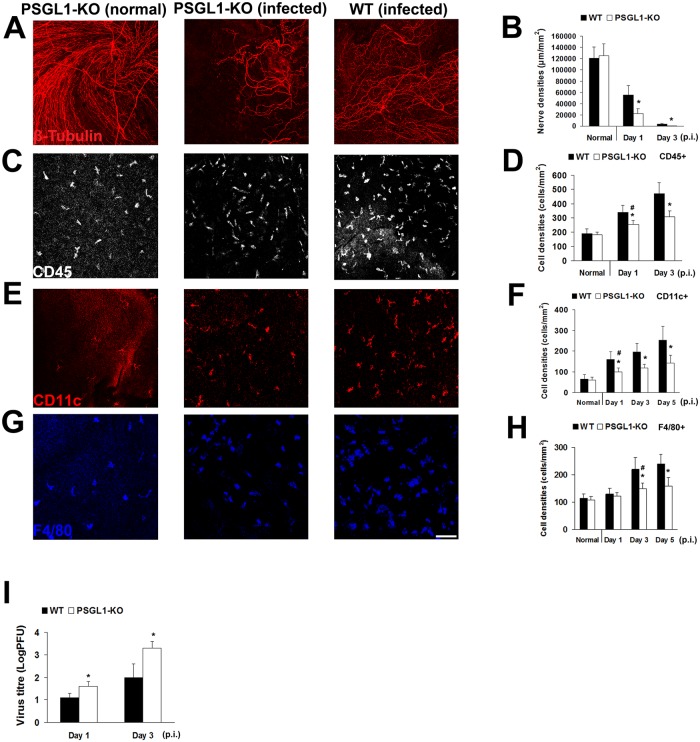
Corneal nerve damage in primary acute herpes simplex keratitis is due to viral proliferation and not corneal inflammation.
A, B: Corneal nerve density was significantly decreased in PSGL1-KO mice as compared to WT mice after HSV-1 infection (n = 5/time point). C, D: The number of corneal inflammatory cells was significantly decreased in PSGL1-KO mice compared to WT mice after HSV infection (n = 5/time points). E, F: Corneal cDC density was significantly decreased in PSGL1-KO mice compared to WT mice after HSV infection. The increase of cDCs in PSGL-1 KO mice as compared to normal controls suggests potential differentiation from progenitor cells or proliferation (n = 5/time point). G, H: The number of corneal MΦs was significantly decreased in PSGL1-KO mice as compared to WT mice after HSV infection (n = 5/time points). I: Corneal viral titers were significantly increased in PSGL1-KO mice compared with WT mice after HSV-1 infection (n = 5/time point). Each experiment was replicated three times. *p<0.05 compared with WT; #
p<0.05 compared with normal (Student’s t-test, two-sided). Data are shown as mean ± SD. Scale bar: 100 μm.